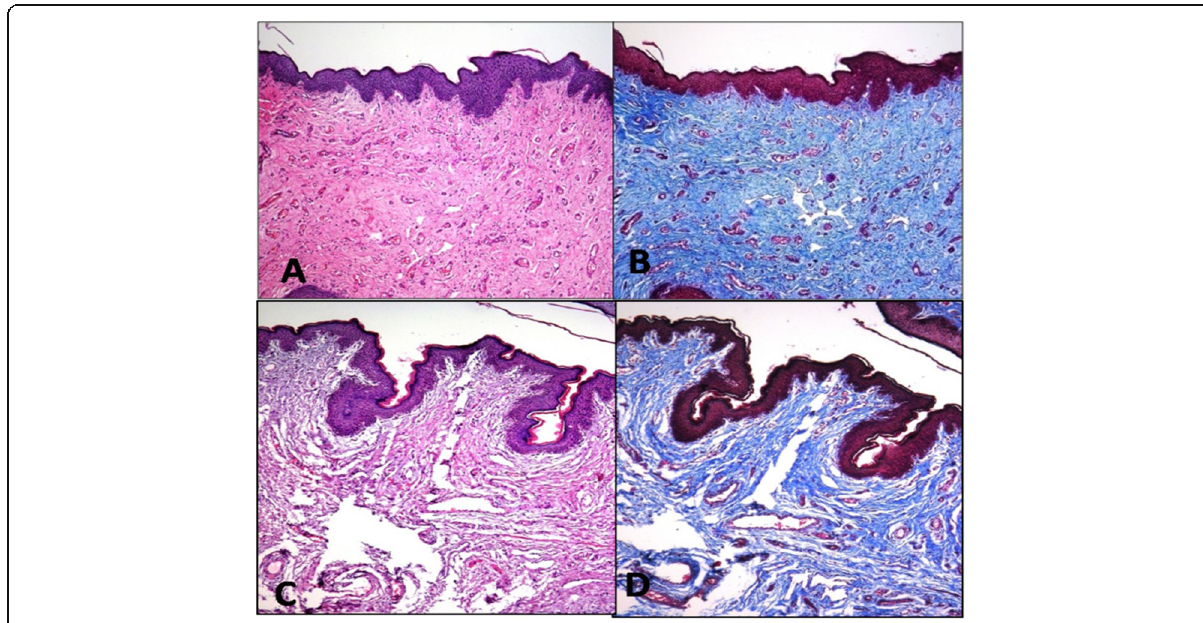
Fig. 3 Genital skin biopsies of hypospadic patients: ( a & b ) testosterone treated group, ( c & d ) untreated group. Biopsies showed surface epithelium overlying vascularized connective tissue with mild to moderate increase in the number of the blood vessels in biopsies of treated group as compared to the other untreated group ( a & c : Hematoxylin and eosin;original magnification × 100, b & d : Masson ’ s trichrome stain;original magnification × 100)